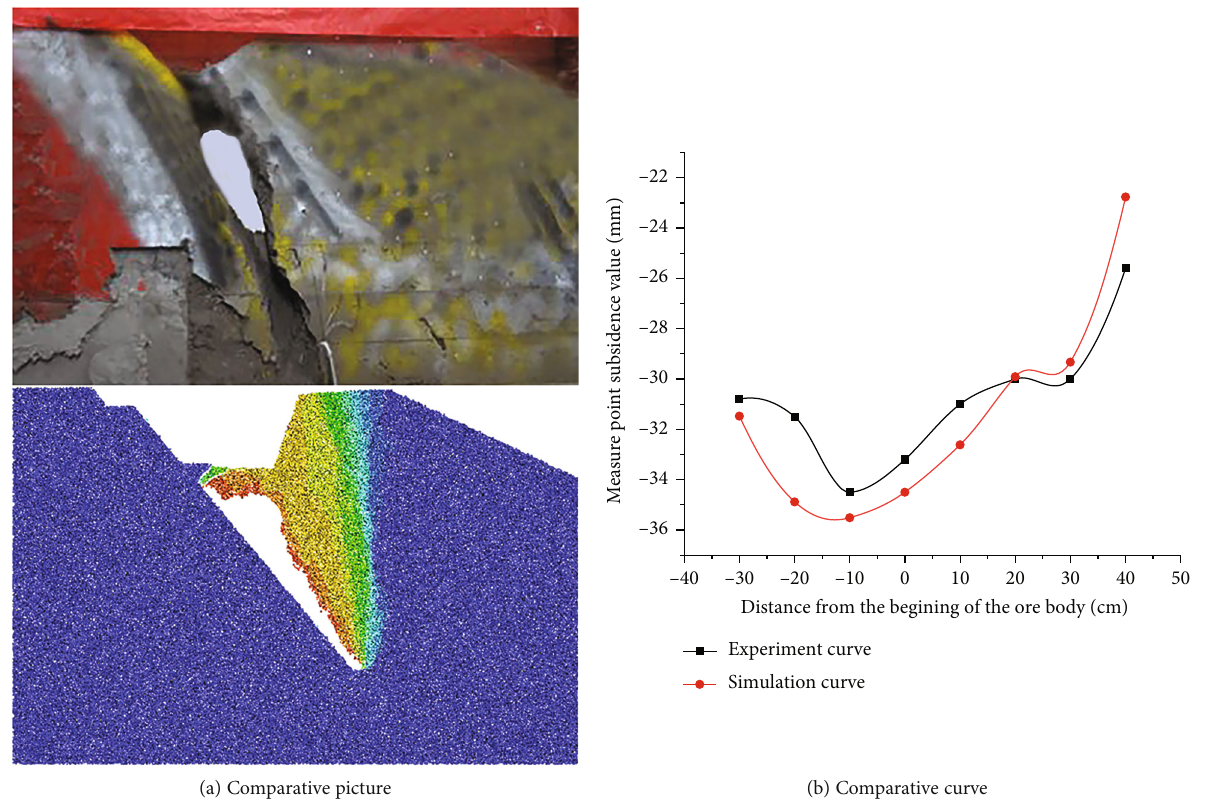
Figure 6: Comparative results of the similar material model and the PFC numerical model. Table 2: The fi nal PFC mesoparameters of the rock